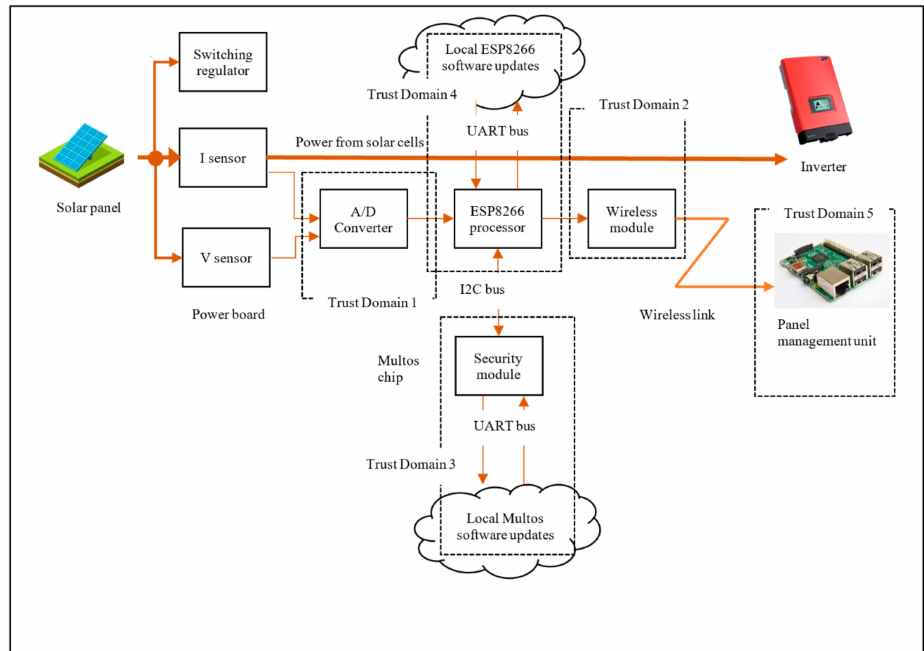
Figure 15. Daedalus Trust Domains with the thin secure